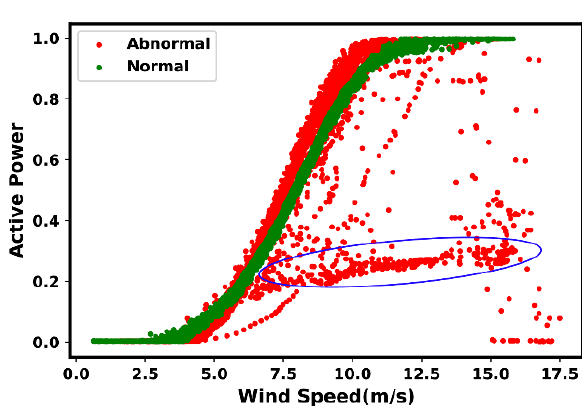
Figure 7. Type 2: Figure 7. Type 2: Down-Rating.